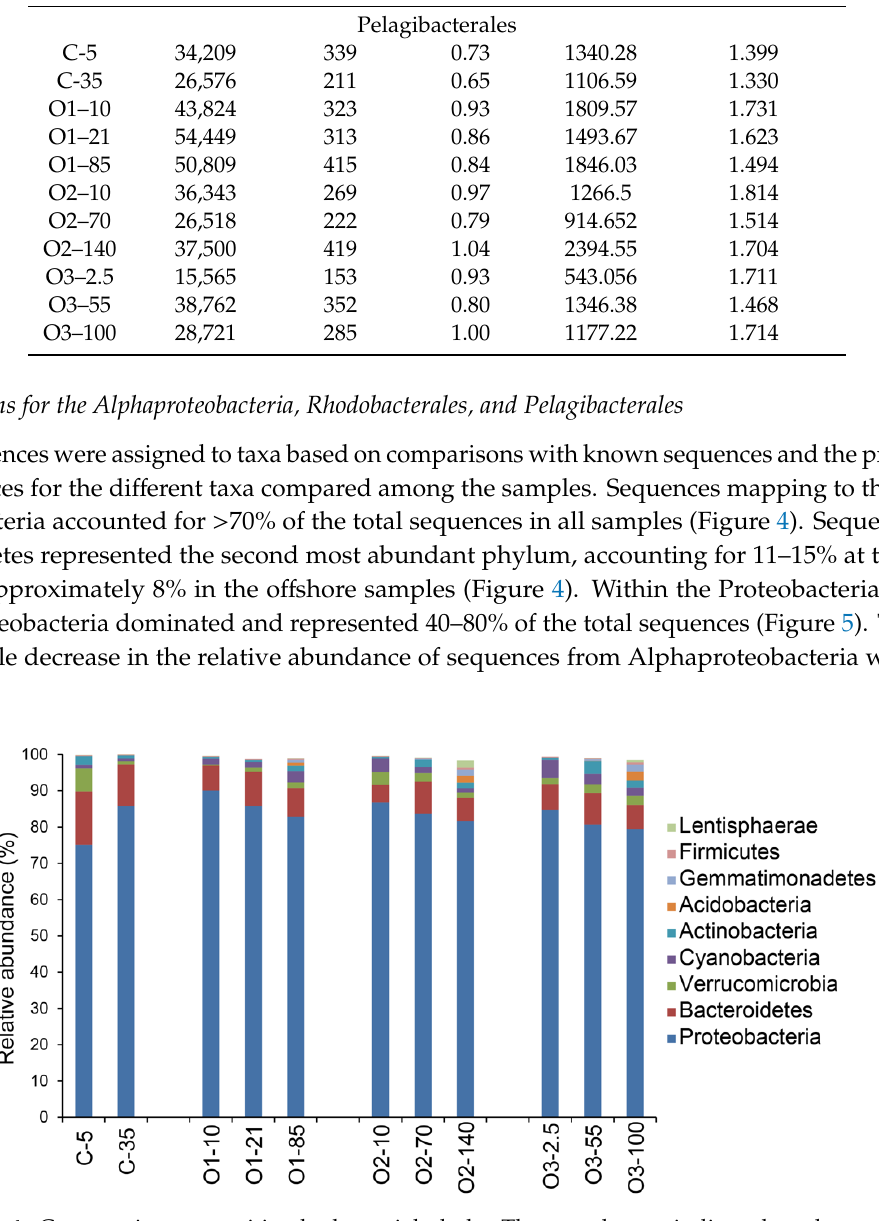
Figure 5. Proteobacterial sequence representation within the bacterial communities. The proportions of sequences from each class are calculated with respect to the total number of sequences obtained for each sample. Below the class level, the Rhodobacterales and Pelagibacterales within the Alphaproteobacteria were the two most dominant taxonomic groups in all samples with the exception of C-35 where the order Rhizobiales represented 19% of all sequences in comparison to 16.6% for Rhodobacterales and 15.2% for Pelagibacterales. The relative proportion of Pelagibacterales was uniformly high in the offshore samples but lower at the coastal site (Figure 6). The highest proportions of sequences from the Rhodobacterales were always found at the surface, where they accounted for 28–41% of the sequences, but they decreased with depth and this was most extreme offshore where their relative abundance dropped to <5% in the deep samples (Figure 6).